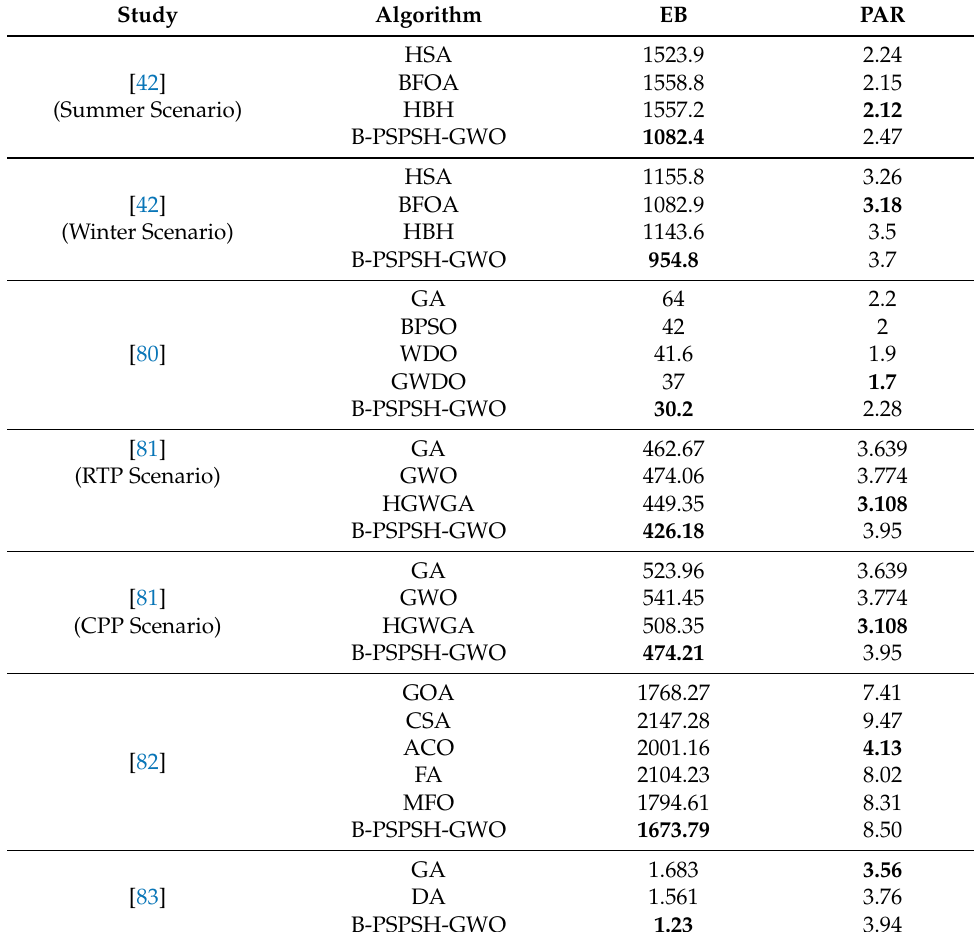
Table 12. Comparison between proposed and the comparative methods.